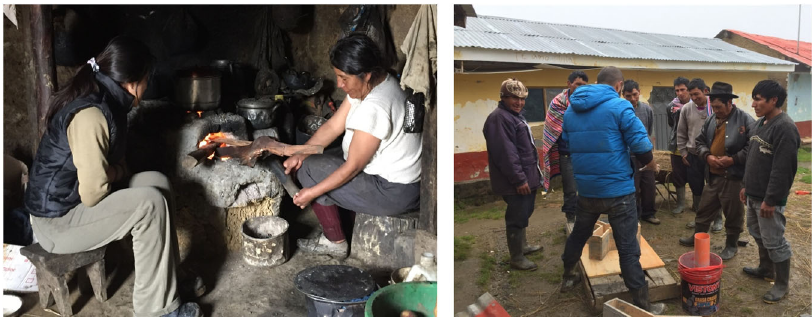
Fig. 3 Rayampampa community involvement through different talks and educational workshops in order to collect and transform insights to key projects. This fi gure shows the participation and involvement of the team with the community, children and adults, and how we support different talks and workshops for the development of the